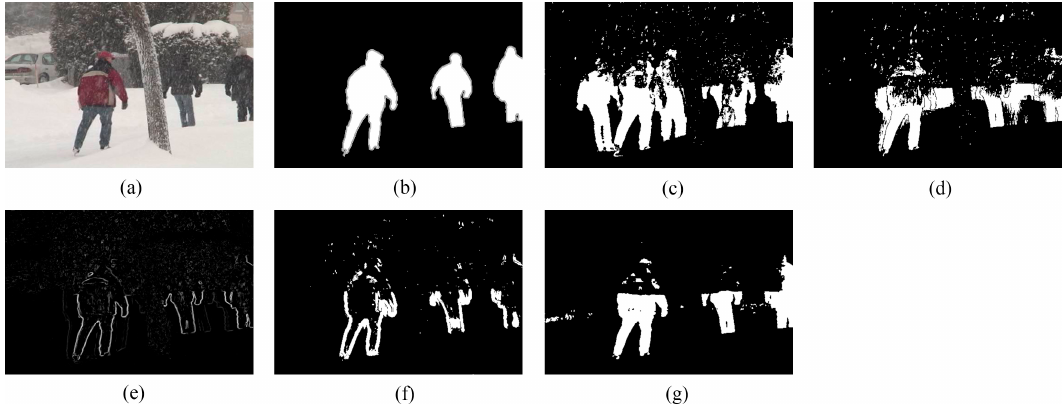
Figure 9. Detection results of the 49th frame of SK96 (Frame 1953): ( a ) input frame; ( b ) ground-truth reference; ( c ) result of ViBe; ( d ) result of PCP; ( e ) result of TD-2DDFT; ( f ) result of TD-2DUWT; ( g ) result of TD-3DDWT. Sensors 2016 , 16 , 456